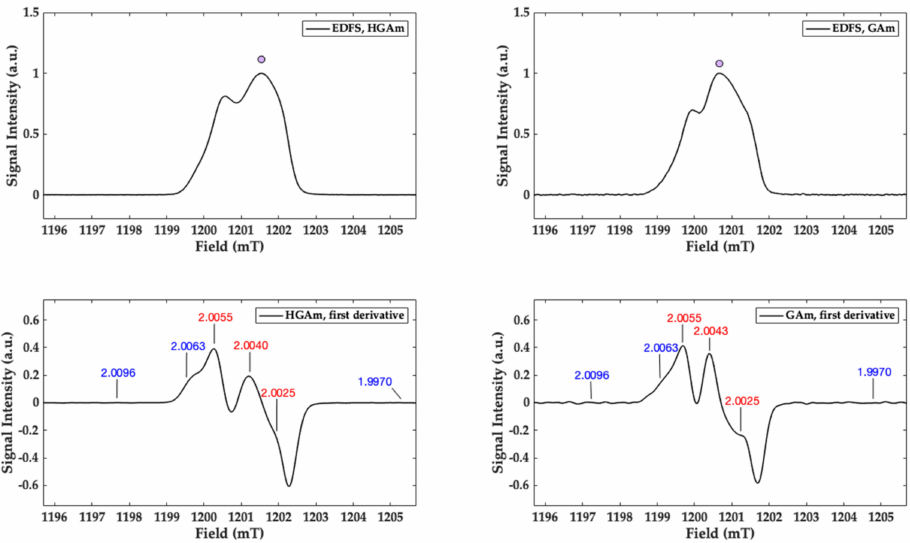
Figure 6. Q-band ( ν = 33.67 GHz) EPR field swept echo detected spectrum (EDFS) recorded at 298 K for the HGAm sample (left panel, up) and the corresponding pseudo field modulation spectrum calculated (left panel down) are reported and compared with the corresponding ones obtained for the GAm pigment (right panel) ( ν = 33.67 GHz). Rectangular pulses were used for the Hahn echo sequence π - τ - π /2, with pulse lengths π = 76 ns and π /2 = 38 ns. The g matrix values for the radical species are